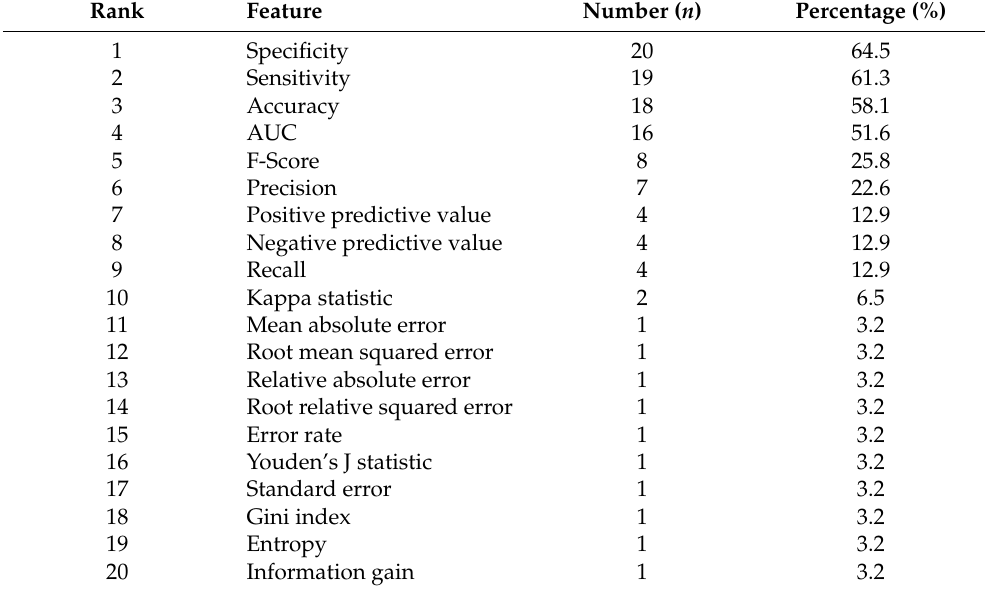
Table 7. Ranking of evaluation metrics. n corresponds to the number of studies using each feature; % is n /31 × 100, 31 being the total of studies included in this